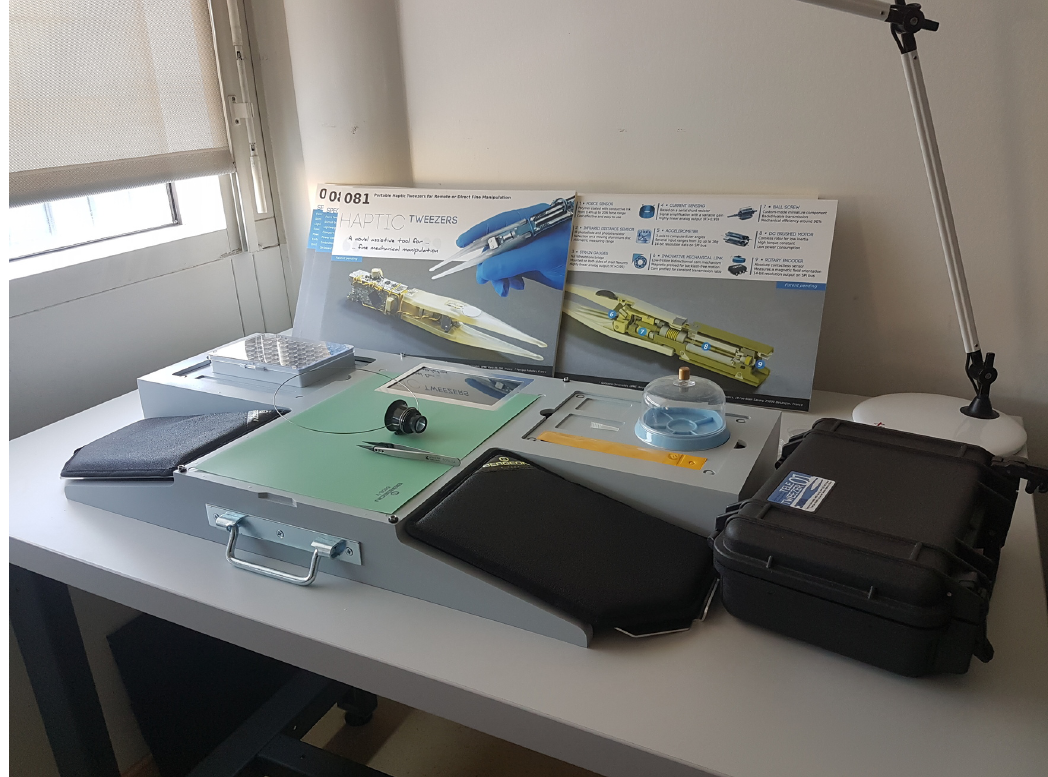
Fig. 5. The workbench designed by ISIR